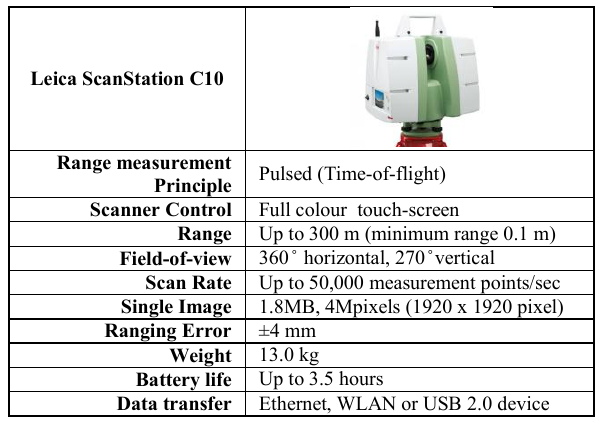
Table 1. Specification Leica ScanStation C10